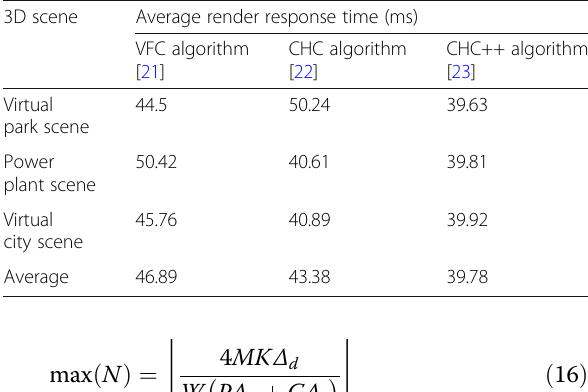
Table 2 The average response time of each test algorithm after blocking